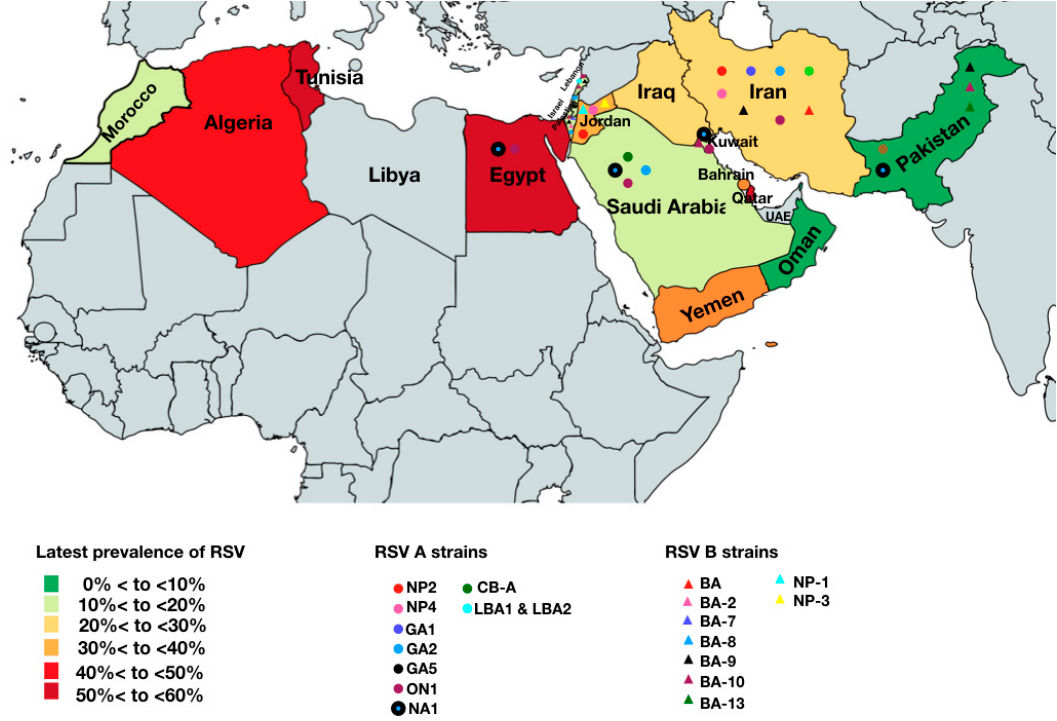
Figure 7. RSV subgroups and strains circulating in the MENA